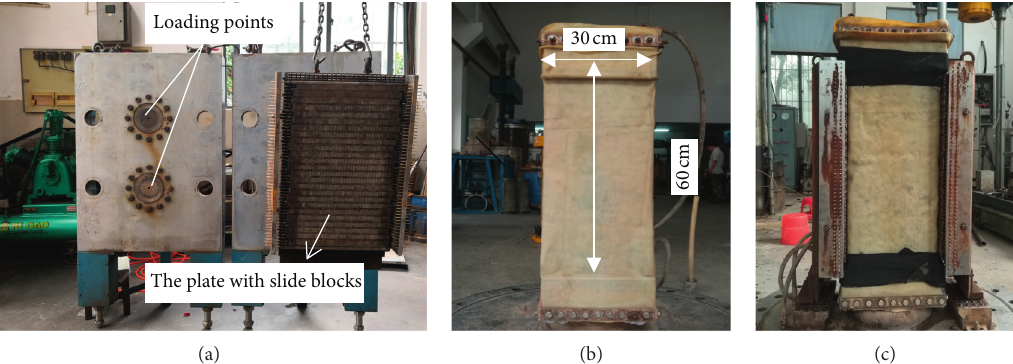
Figure 5: Specimen and setup of lateral plates: (a) friction-reduction plate; (b) specimen in the true triaxial test; (c) installation of internal lateral